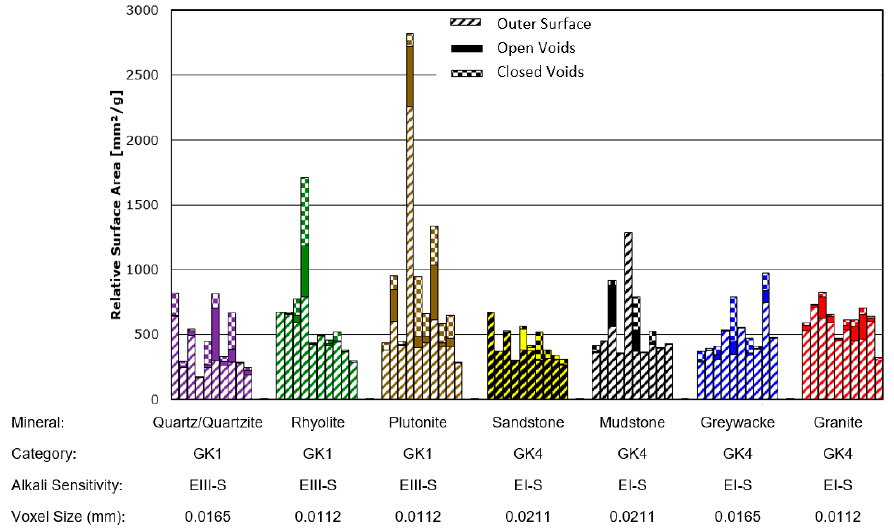
Figure 13. Measured surface area for river-gravel type aggregates (based on figure in [10]).